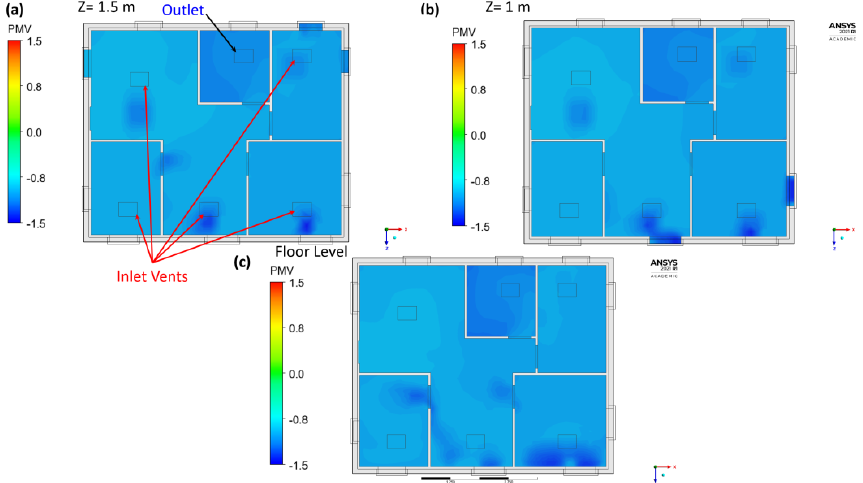
Figure 10. The predicted mean vote (PMV) profiles distribution for the house (top view) using Healthy Home standards 2019 inlet temperature 20 ℃ at different heights ( a ) 1.5 m, ( b ) 1 m, and ( c ) the (finished) floor.